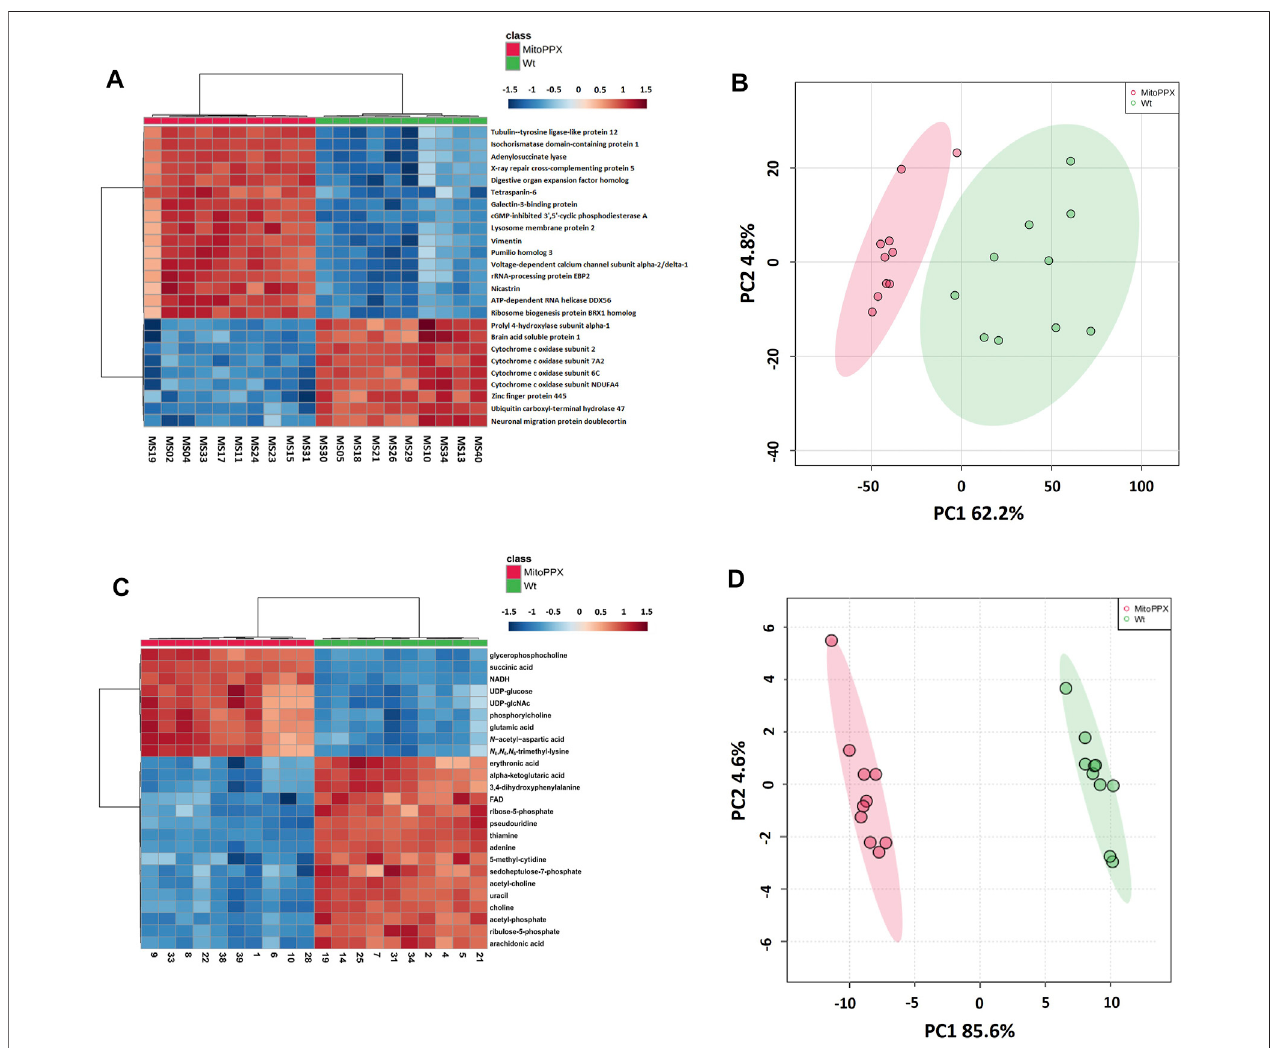
FIGURE2| Heatmapsandprincipalcomponentanalysis(PCA)showedthatSH-SY5YWtandMitoPPXhavedifferentproteomicsandmetabolomicspro fi les.Heat mapsidenti fi edthetop25mostsigni fi cantlyexpressedproteins( t -test p -value < .05) (A) andmetabolites( t -test p -value < .05) (C) detectedinMitoPPXcellswithrespectto Wt cells, some of them related to the status of mitochondrial physiology. Red colors depict proteins or metabolites that were upregulated in the MitoPPX cells and blue colorsdepictthose downregulatedinthesamesamples. PCA identi fi edclear separationbetweengroups forboth proteomics (B) and metabolomics (D) datasets. Shaded areas depict regions with at least 95% con fi